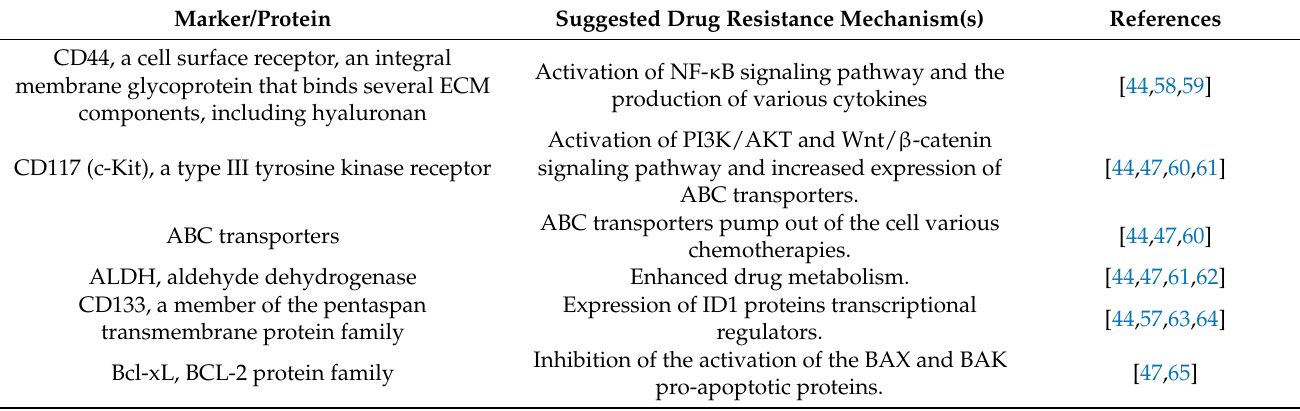
Table 2. Ovarian cancer stem cells and drug resistance